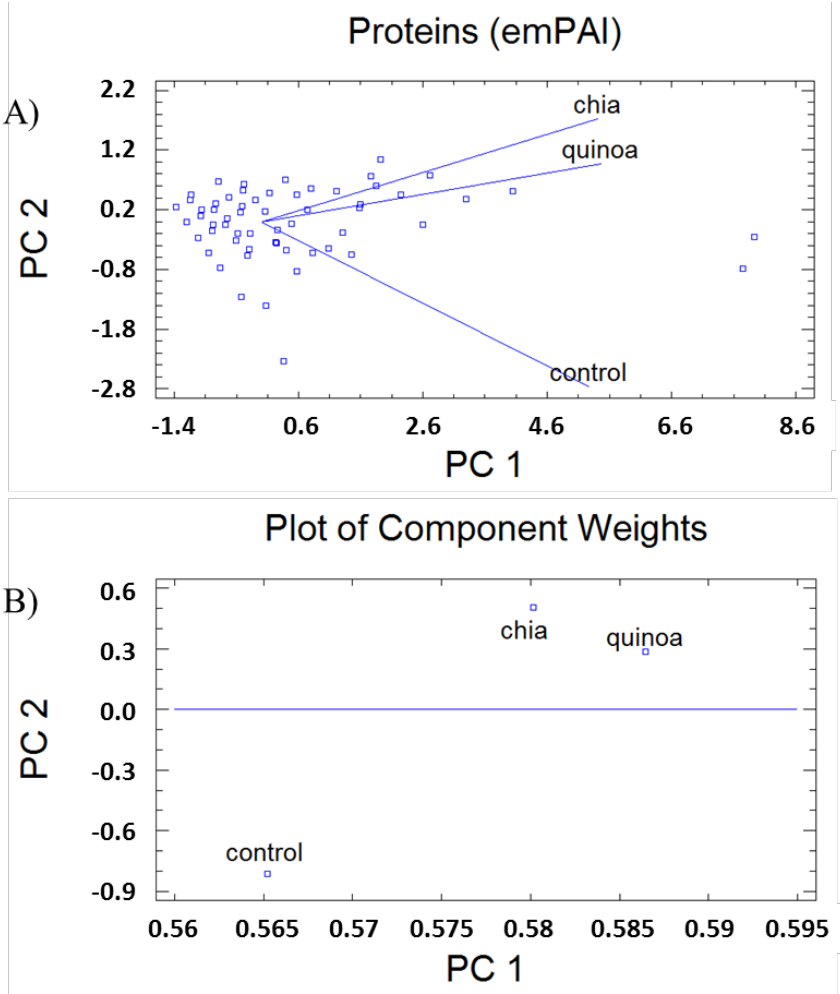
Figure 4. Principal component (PC) analysis ( A ) and plot of coefficients representing component weights (correlation coefficients between the studied factor and variables) ( B ) of changes in the proteome of human-like macrophage cells incubated with extracts from Chenopodium quinoa (quinoa) or Salvia hispanica L (chia) in comparison to untreated control cultures.